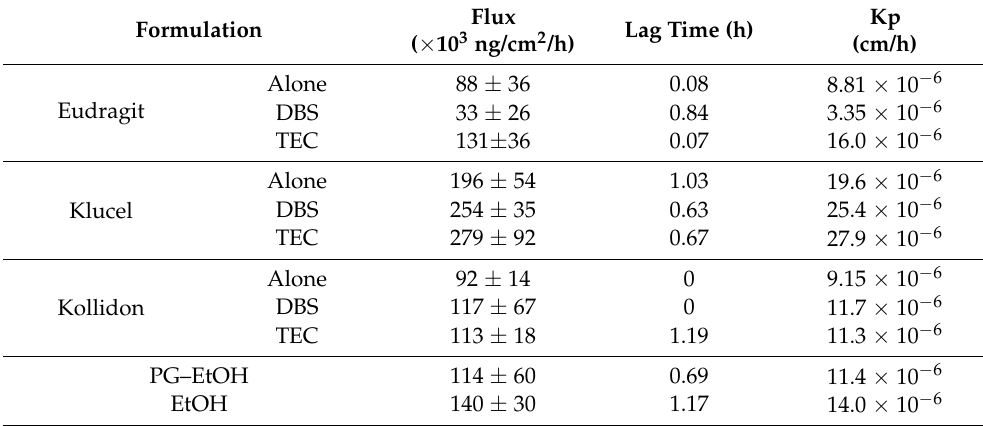
Figure 1. Cumulative amount of hydrocortisone (HC) that permeated across the Strat-M membrane per surface area (ug/cm 2 ) in time ( n = 4, average ± SD) upon application using different formulations (triethyl citrate (TEC), tributyl citrate (TBC), dibutyl sebacate (DBS), propylene glycol (PG) and ethanol (EtOH)). Table 3. Permeation parameters for hydrocortisone (HC) when applied to the Strat-M membrane (average ± SD, n =